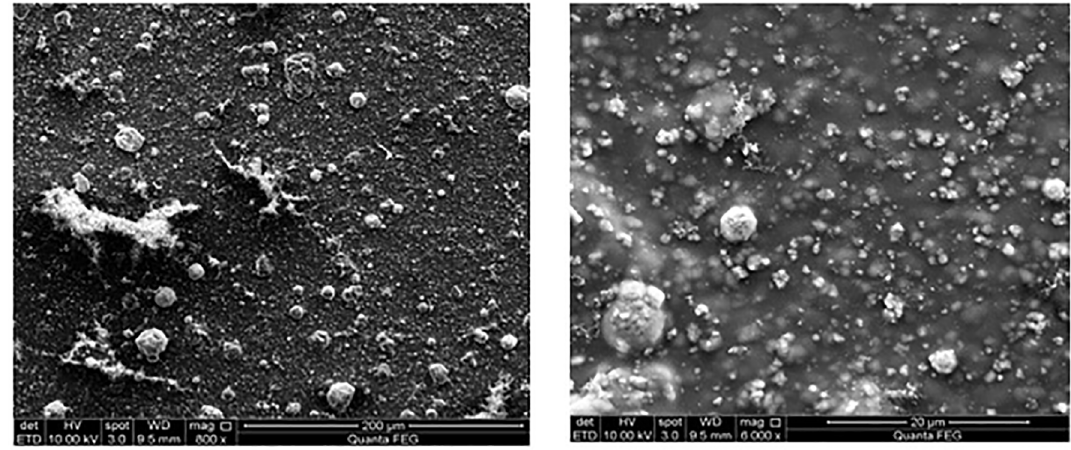
Figure 6: SEM images of the hybrid TiO